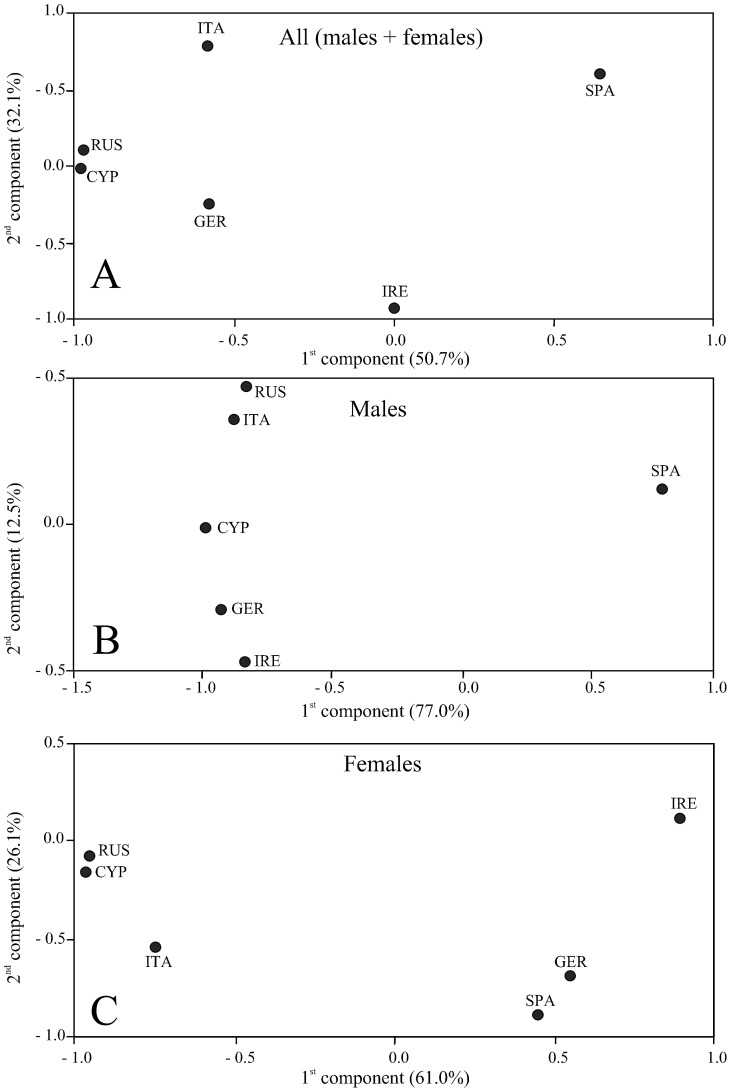
The Principal Component Analysis performed using the average pairwise F
ST distance values among STR genotypes.The percentage of total variance explained by each of the first two components is given. (A) All individuals. (B) Only males. (C) Only females.